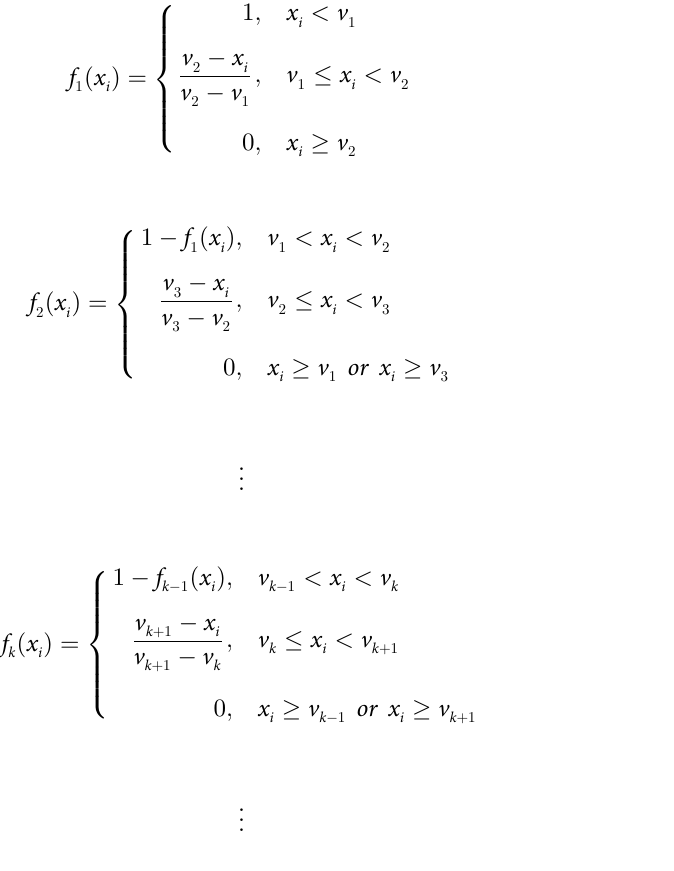
tive descriptive statement), with the quantitative criteria for each evaluation grade V = { v � � � , v , � � � , v }. The semi-trapezoidal and triangular membership functions are used to deter- k m mine the fuzzy membership of the index, that is, by dividing the demarcation point on the con-